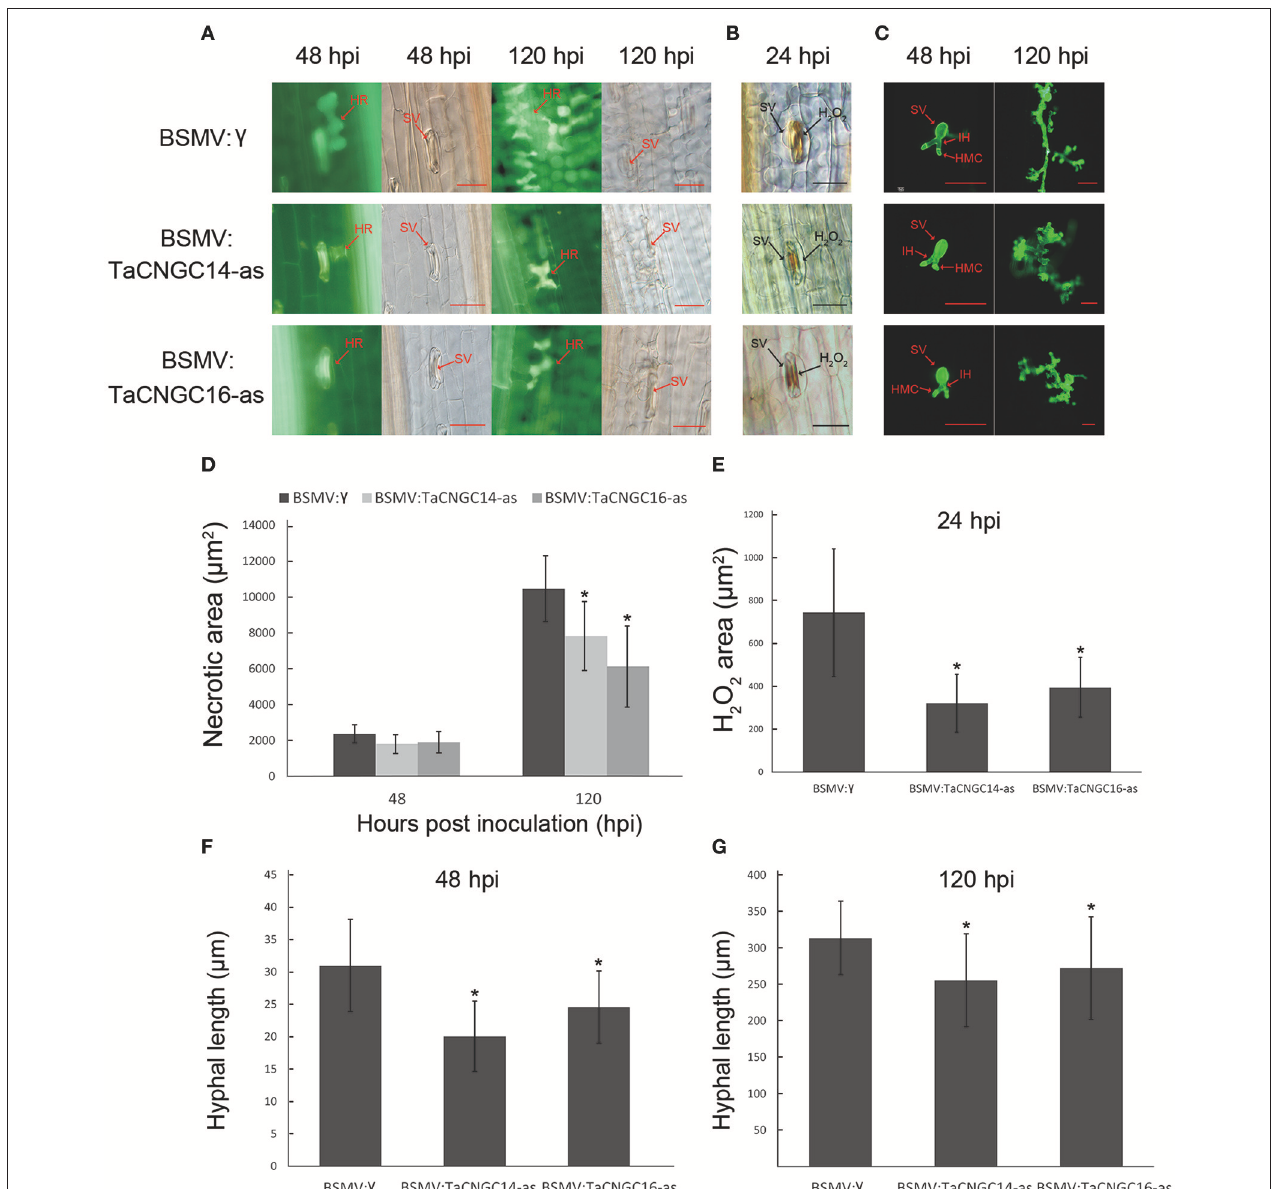
FIGURE 7 | Histological observation of HR, H 2 O 2 area, and fungi development. (A) The silencing leaves were inoculated with CYR23, and the necrotic area necrotic mesophyll cell around an infection site was performed during 48 and 120 hpi by epifluorescence. Mock was treatment with BSMV: γ . (B) H 2 O 2 accumulation was counts at 24 hpi around the infect area by staining with DAB. (C) Wheat germ agglutinin (WGA) was used to stain the leaves to visualize pathogen. (D) Necrotic area was measured at 48 and 120 hpi. (E) H 2 O 2 area was measured at 24 hpi. (F–G) Hyphal lengths were measured at 48 hpi (F) and 120 hpi (G) . Asterisks represent a significant differences ( P < 0.05) from BSMV: γ by the Tukey’s HSD test. HR, hypersensitive reaction; SV, sub-stomatal vesicle; IH, primary hyphae; HMC, haustorial mother cell. Those data were collected from 30 infection sites. Hpi, hours post-inoculation; Bar, 50 µ